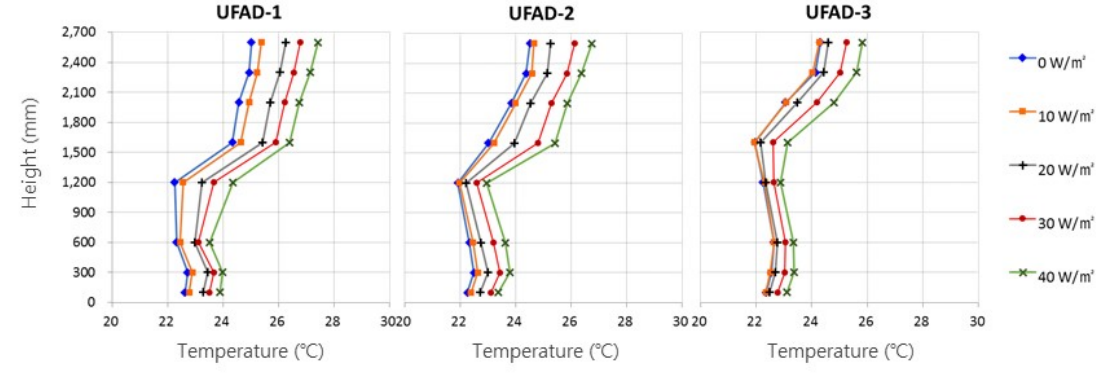
Figure 14. Vertical temperature distribution at (X1, Y2), UFAD.